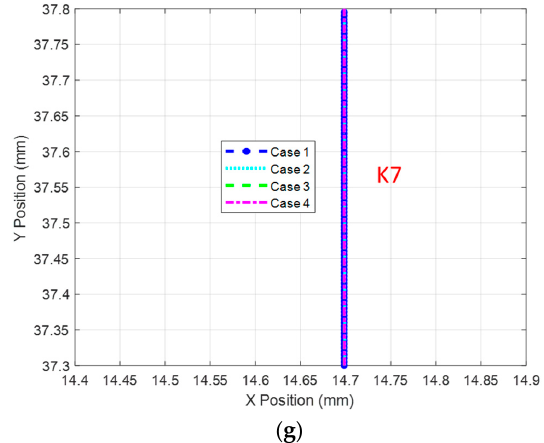
Figure 12. Experimental contour for Cases 1 to 4: ( a ) overview, ( b ) period K2, ( c ) period K3, ( d ) period K4, ( e ) period K5, ( f ) period K6, and ( g ) period K7.